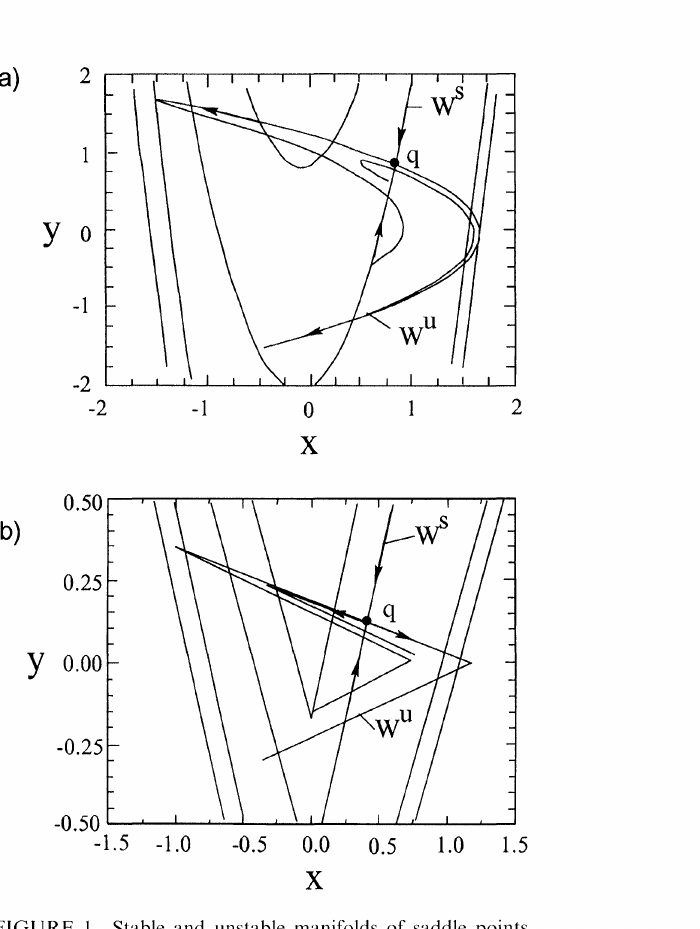
Stable and unstable manifolds of saddle points in the Henon map and the Lozi map. (a) The manifolds of the saddle in map (1) for a= 1.3 and b=0.3 and (b) the manifolds of the saddle in lnap (2) for a 1.7 and b